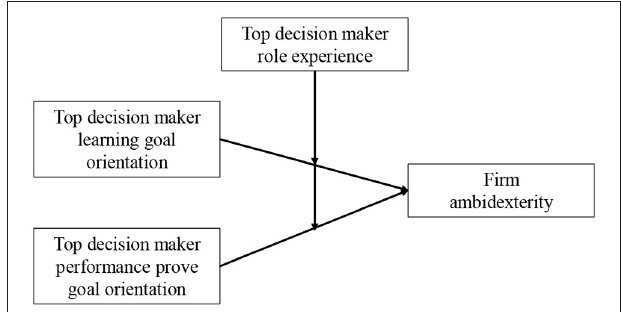
FIGURE 1 | Top decision makers’ goal orientation, role experience, and firm